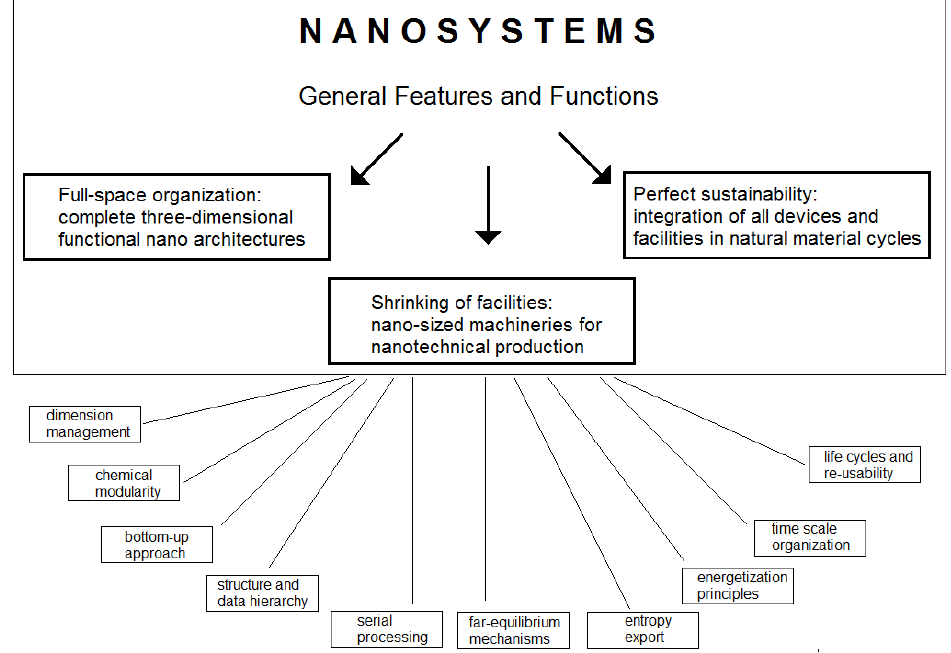
Figure 1. Fundamental requirements for future nanosystems.